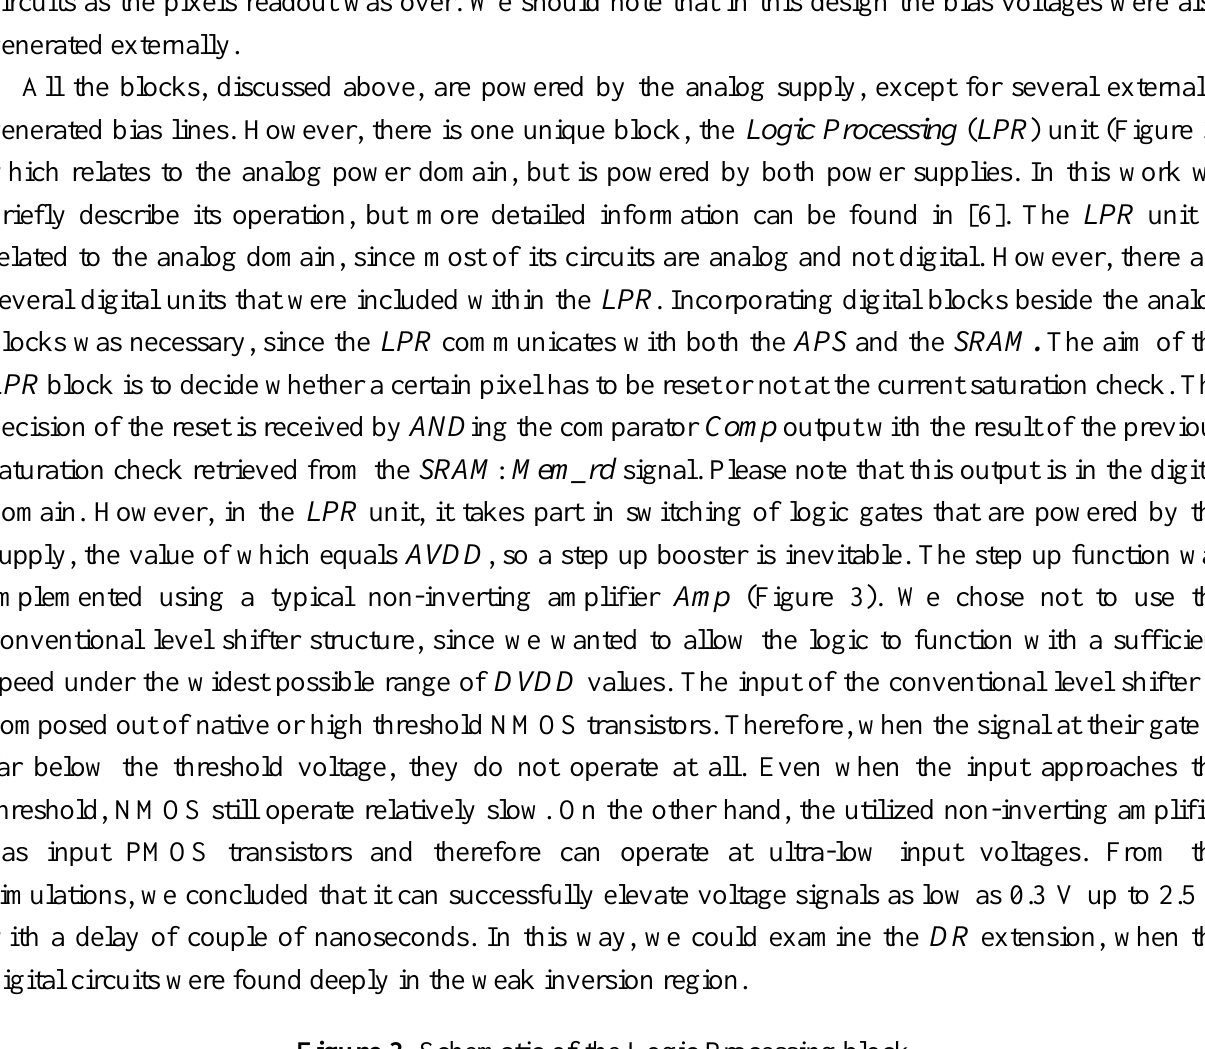
Figure 3. Schematic of the Logic Processing